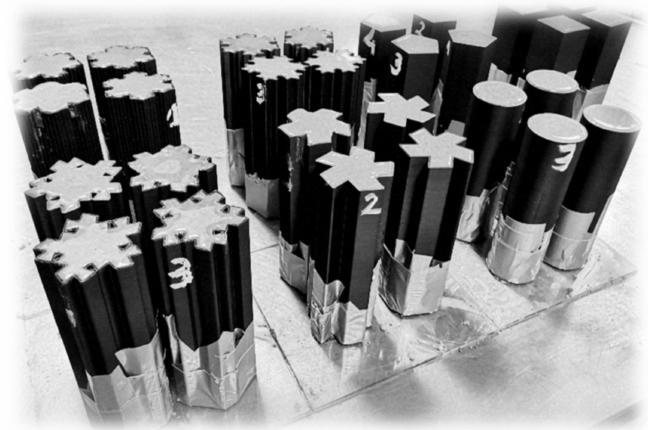
Figure 2. Cast concrete–plastic